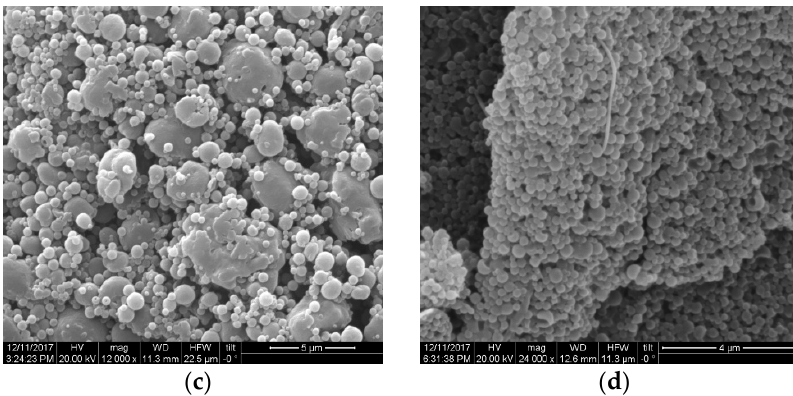
Figure 5. Morphology of lignin isolated with traditional OS pretreatment with 60% v/v ethanol content ( a ) and after homogenization at 500 bar in ethanol/water solution with ethanol content of ( b ) 0% v/v ; ( c ) 50% v/v ; and ( d ) 75% v/v . Table 1. Determination of particle size, polydispersity index, and zeta potential of lignin micro- and nanoparticles isolated in the present